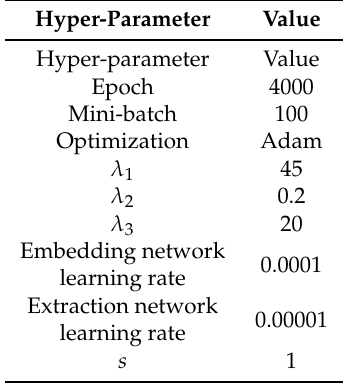
Table 3. Hyper-parameters used in